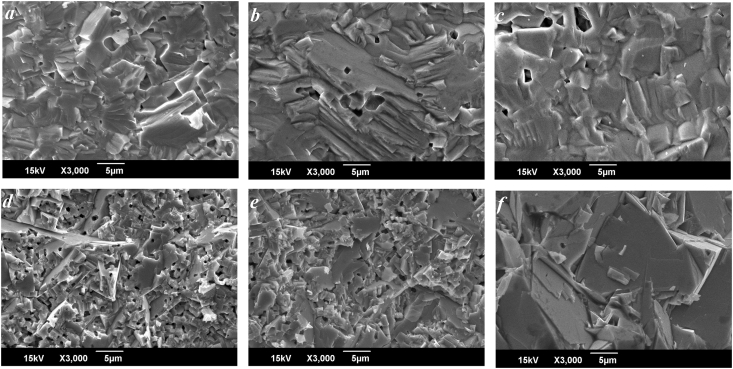
Fragments of the microstructure of the NCN ceramics obtained at various TSin: x = 0.10 (a–c); x = 0.25 (d–f); (a, d) TSin = 1520 K; (b, e) TSin = 1570 K; (c, f) TSin = 1620 K.